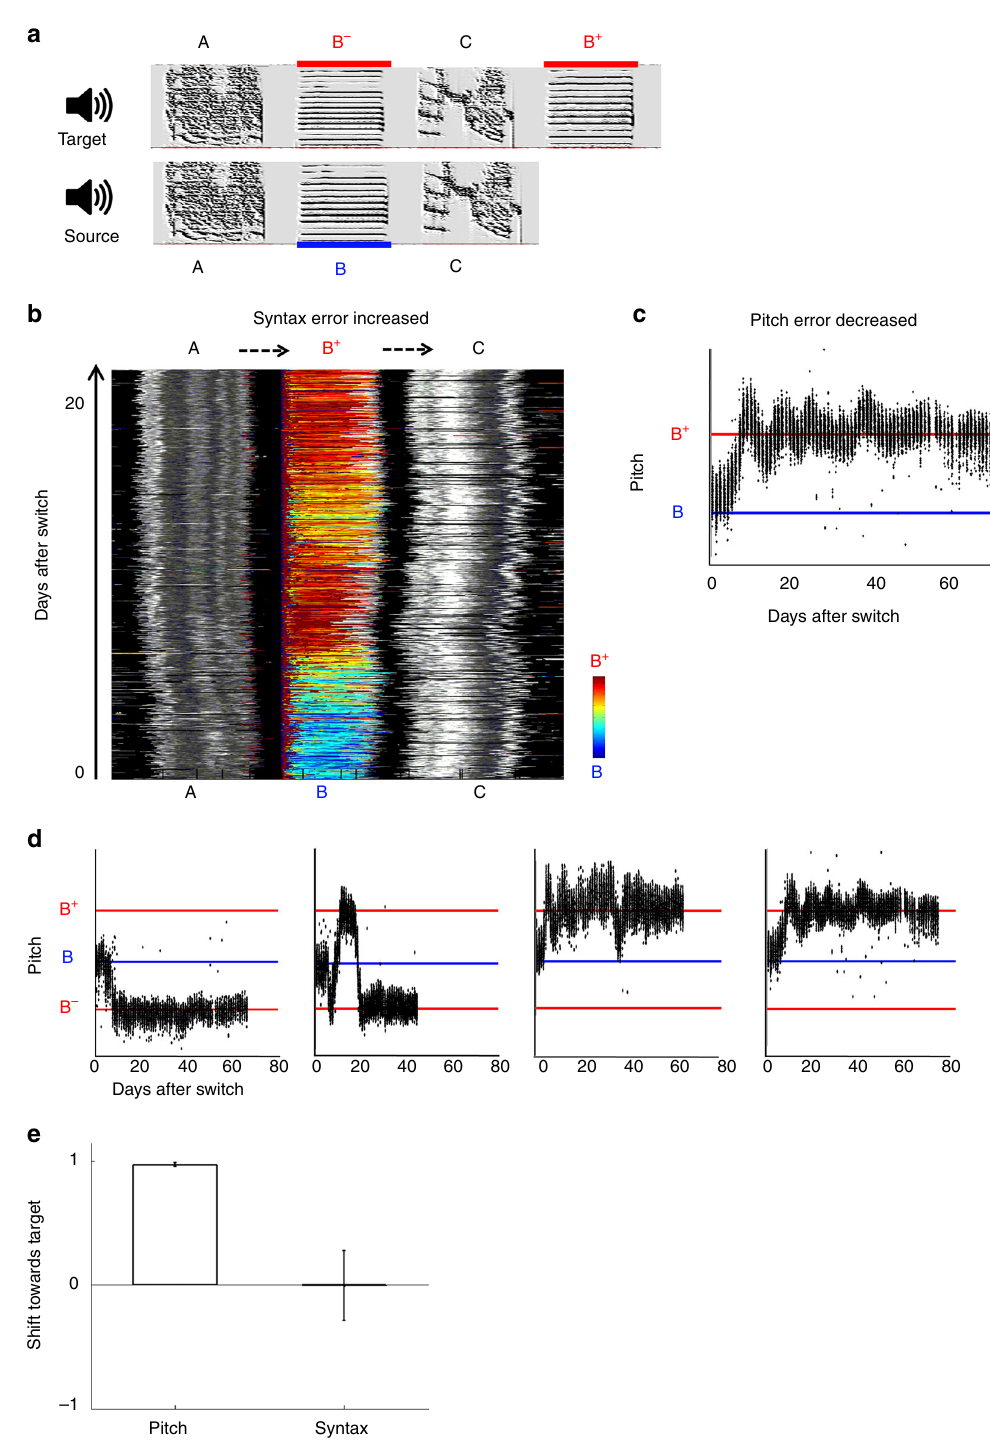
Fig. 3 Phonological error correction is independent of temporal context. a In imitation task 3 (ABC → AB − CB + ) syllable B in the source song is replaced by two similar, equidistant syllables in the target song: B − in the same sequential context and B + in a different context. b Stack plot of song motif ABC renditions in one experimental bird (colors as in Fig. 2b). Syllable B shifted to become target syllable B + , resulting in a decrease in syntax match due to acquisition of incorrect syllable transitions AB + and B + C (dashed arrows). c The median pitch per syllable for all B/B + renditions in the same experimental bird, showing accurate matching of the target syllable B + . d Pitch trajectories of experimental birds trained with the task ( n = 4). Two birds shifted pitch down to the in-context target B − (in one case after oscillations), and two others shifted pitch up to the out-of-context target B + . e Pitch and syntax shift towards target at developmental endpoint (0, source pitch/syntax; 1, full match of target pitch B − or B + /full match of target syntax ( fi rst 3 syllables), de fi ned as 100% performance of correct transitions; − 1, syntax maximally shifted away from target, de fi ned as 100% performance of incorrect transitions; means ± s.e.m. across